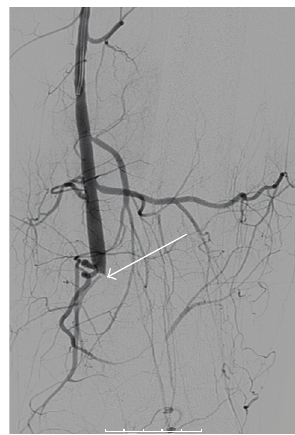
Figure 1: Angiogram of the left leg before thrombolysis, showing complete occlusion of the popliteal artery.